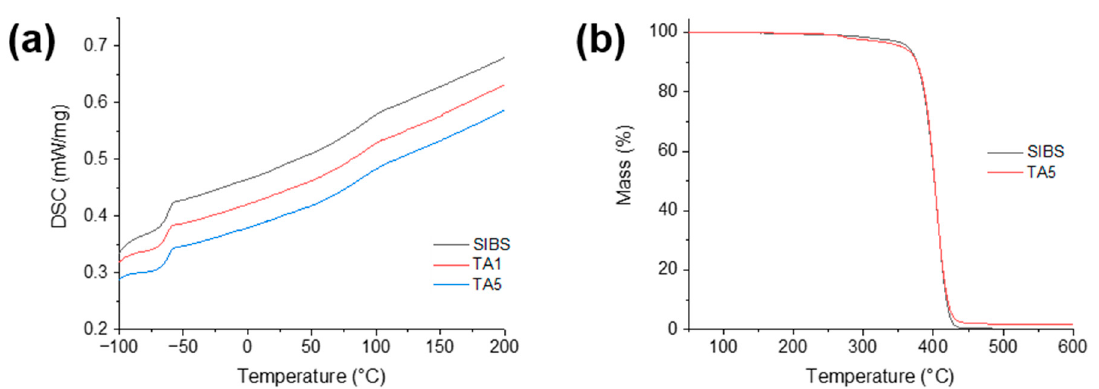
Figure 2. ( a ) Differential scanning calorimetry (DSC) measurements of SIBS and formulations with TA at different weight percentages (1 wt % and 5 wt %). ( b ) Thermogravimetric analysis (TGA) measurements of SIBS and its formulations with the drug.